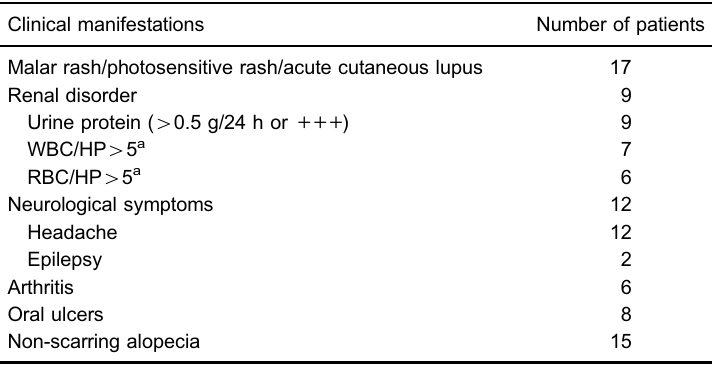
Table 2. Clinical manifestations of patients with active systemic lupus erythema- tosus (n=17). Clinical